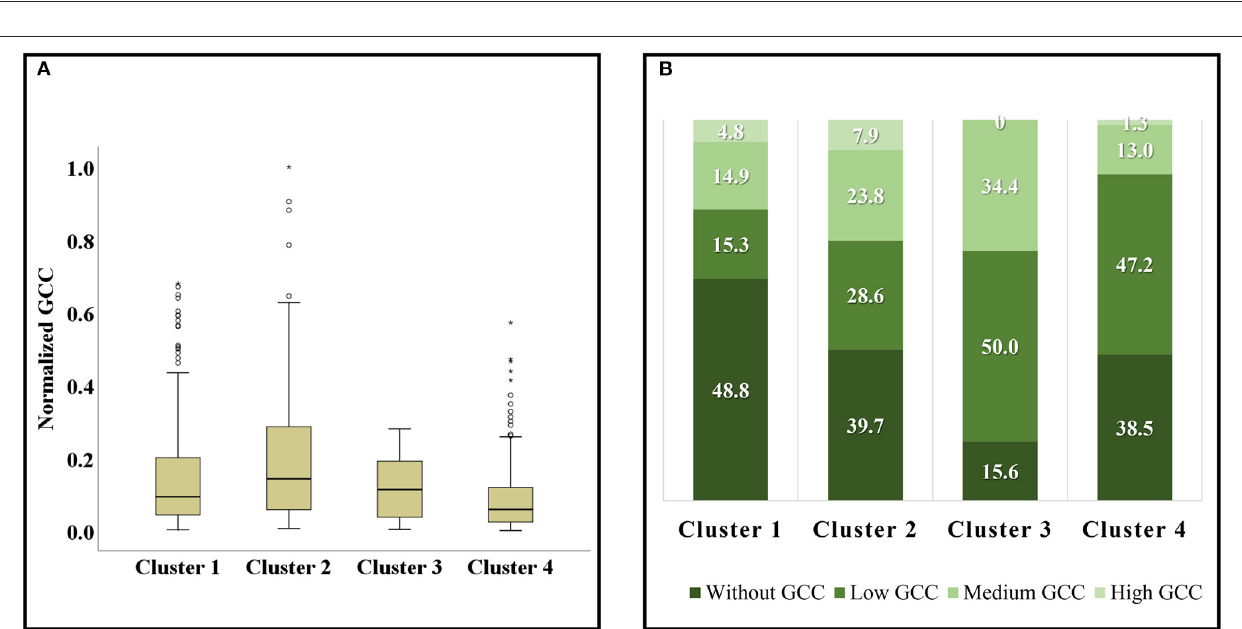
FIGURE 9 | The box diagram of GCC distribution in different urban zones (A) , proportion of green spaces with different levels of GCC in different zones (B) . Hollow circles ◦ represent mild outliers; asterisks * represent extreme outliers.